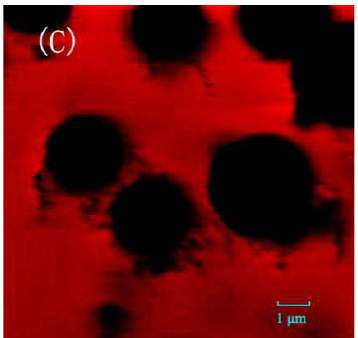
Figure 4. ( a ) SEM image of the jellified CALB@PE droplets; confocal laser scanning microscopy (CLSM) images of CALB@PE of FITC-Dex in water ( b ) and Nile red in toluene ( c ), respectively.